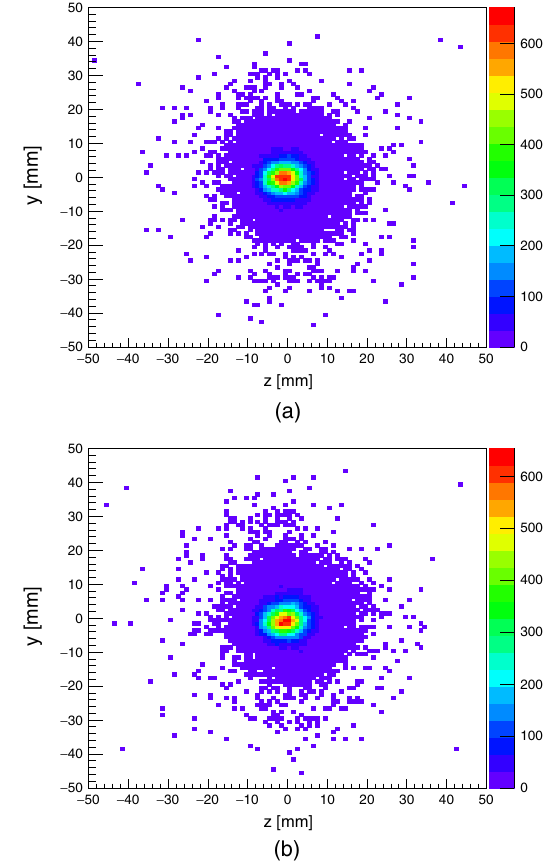
FIG. 22. Comparison of the 15-keV muon beam spots at the sample position under the influence of different stray fields: current μ E 4 with (a) quadrupole triplet and (b) solenoid WSY, model-3.